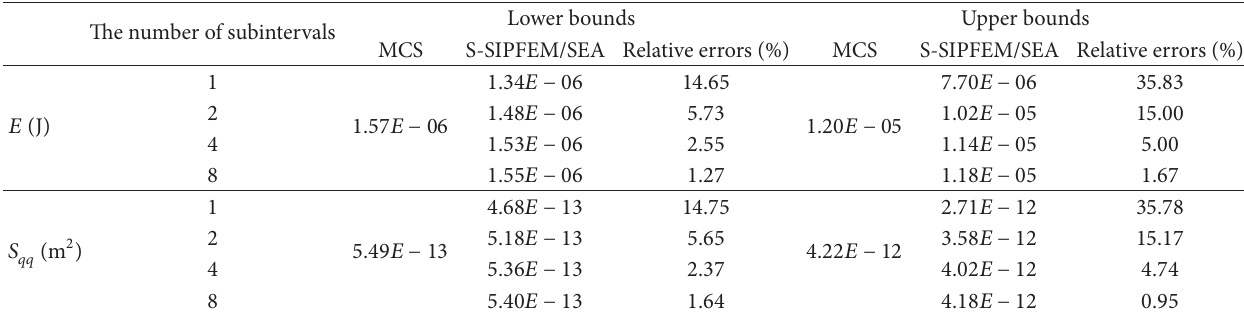
Table 3: The relative errors of the bounds of the plate energy and the autospectra of the mass displacements yielded by S-SIPFEM/SEA with different subinterval numbers ( 𝑓 = 170 Hz).